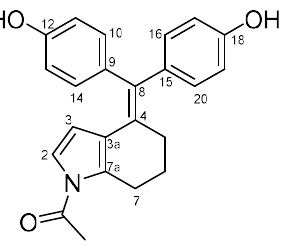
Scheme 19. Structure of 32 with the numbering of atoms used for the assignment of NMR data.